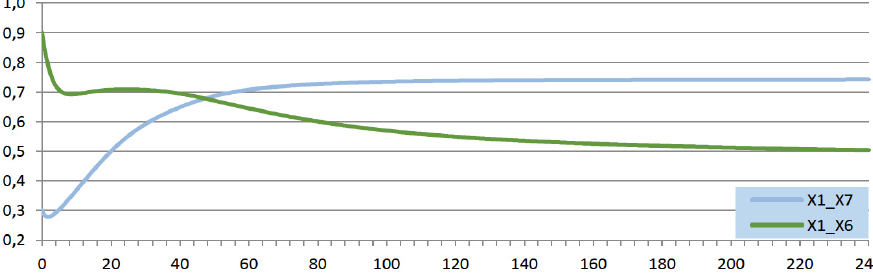
Fig. 3. Simulation results for suppression and Hebbian learning for ! 1 (connection X 1 – X 6 ) and ! 2 (connection X 1 – X 6 ) (Scenario